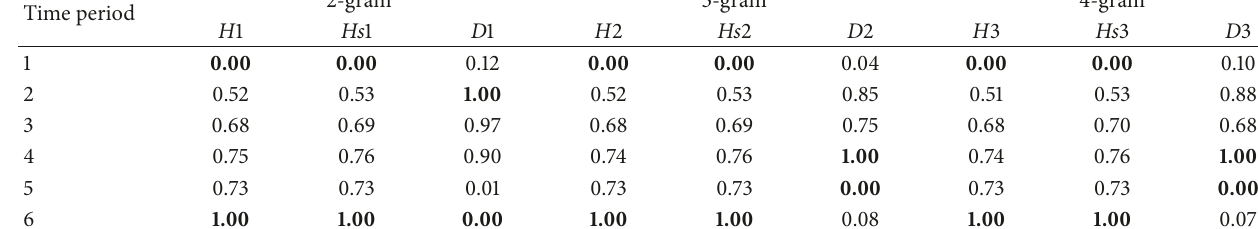
Table 4: Evolution of 2-, 3- and 4-gram word length entropies compared with the entropies of the shuffled texts (with normalized values). Time period